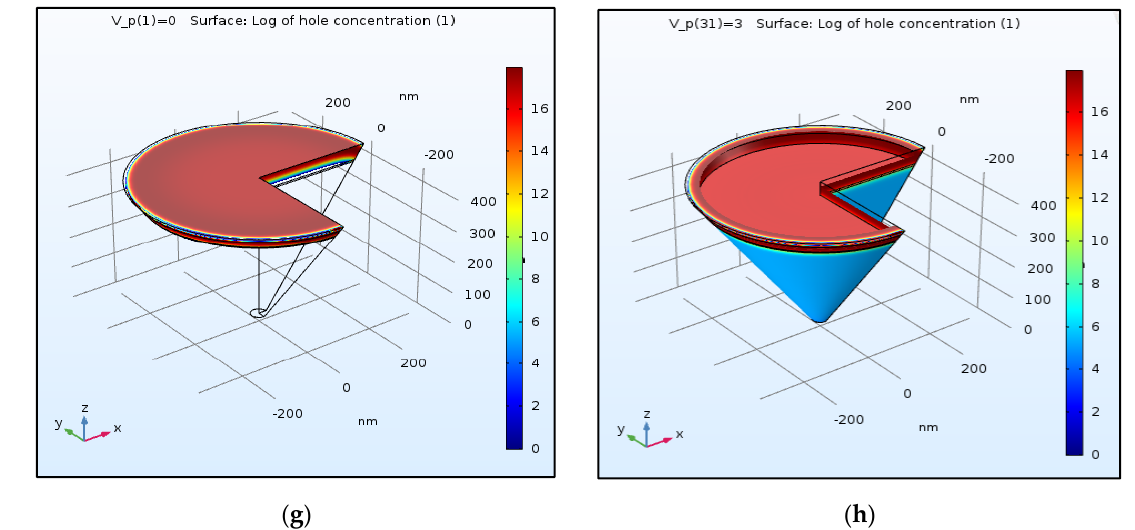
Figure 5. 3D simulations of electrons and holes concentration in conical shape (LENS) at equilibrium (no voltage bias) and at 3V. Color Log distribution scale in cm − 3 . T = 300K, λ = 450 nm, E gap = 2.75 eV. 3D LED: ( a ) electrons, V = 0V; ( b ) electrons, V = 3V; ( c ) holes, V = 0V; ( d ) holes, V = 3V. Three-dimensional LENS: ( e ) electrons, V = 0V; ( f ) electrons, V = 3V; ( g ) holes, V = 0V; ( h ) holes, V = 3V.